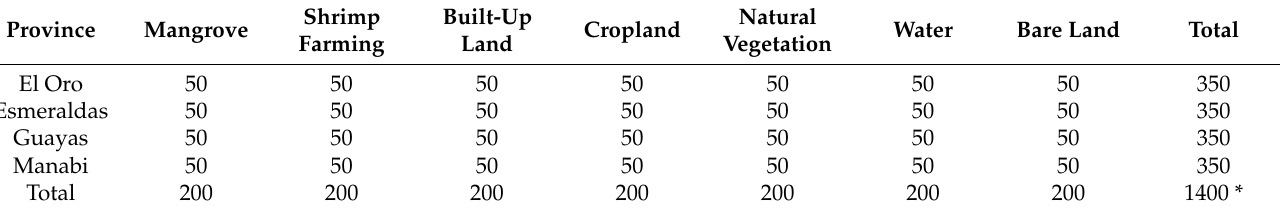
Table 4. Details of sample points by province and LUC.